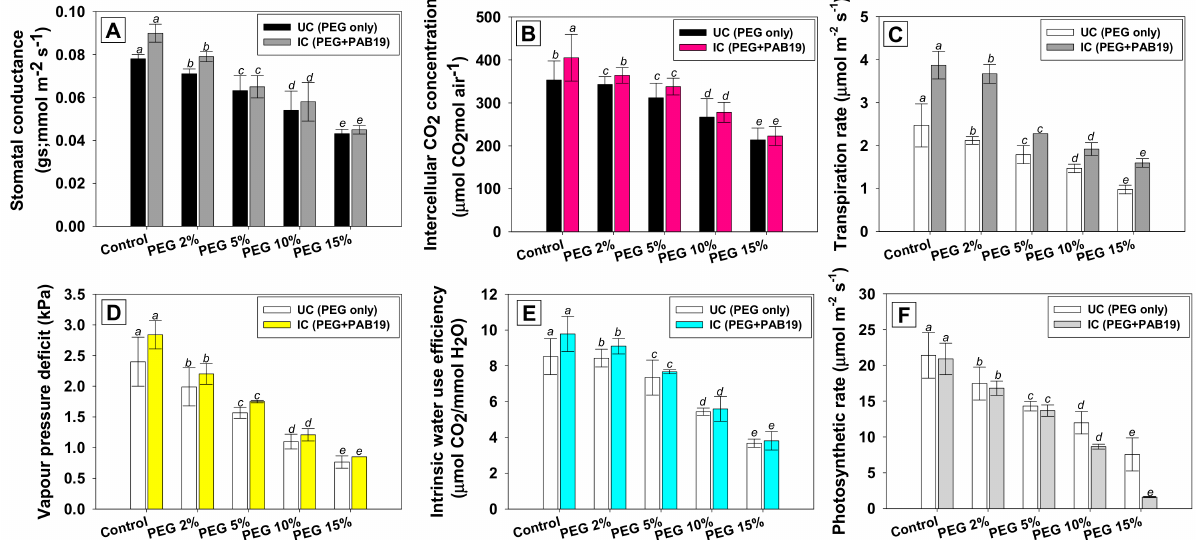
Figure 8. Impact of Enterobacter sp./ L. adecarboxylata PAB19 on gas exchange parameters; stomatal conductance ( A ), intercellular CO 2 concentration ( B ), transpiration rate ( C ), vapor pressure deficit ( D ), intrinsic water use efficiency ( E ), and photosynthetic rate ( F ) of V. radiata cultivated in the presence of different levels of water stress under green-house conditions. Bar and scatter plots represent means ± SDs. Mean values followed by different letters are significantly different ( p ≤ 0.05) as determined by the